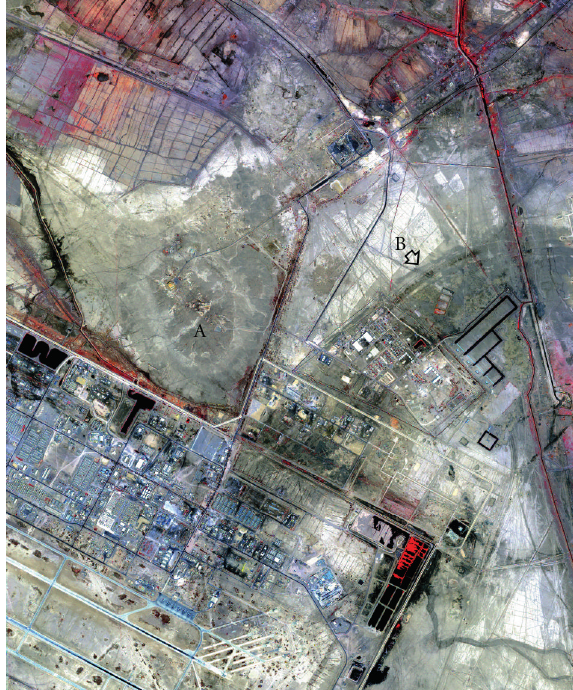
Figure 13: Ur (A) and the surrounding territory in a pan-sharpened Ikonos-2 image of 2008 (colour composite RGB bands 4-3-2): only some traces (B) of the paleo river bed of the Euphrates are